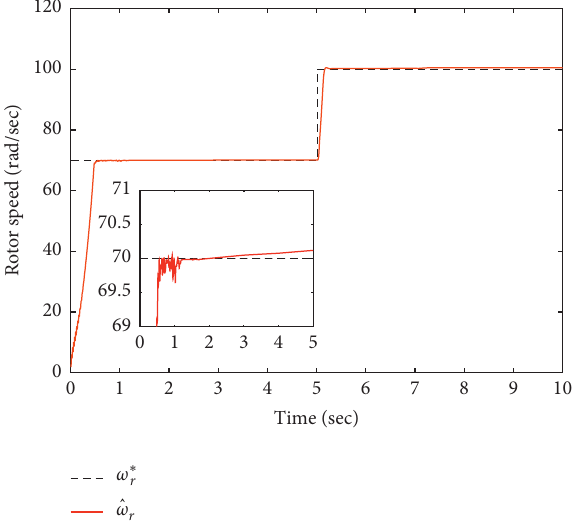
Figure 12: Evolution of output—super-twisting control (noisy measurements).